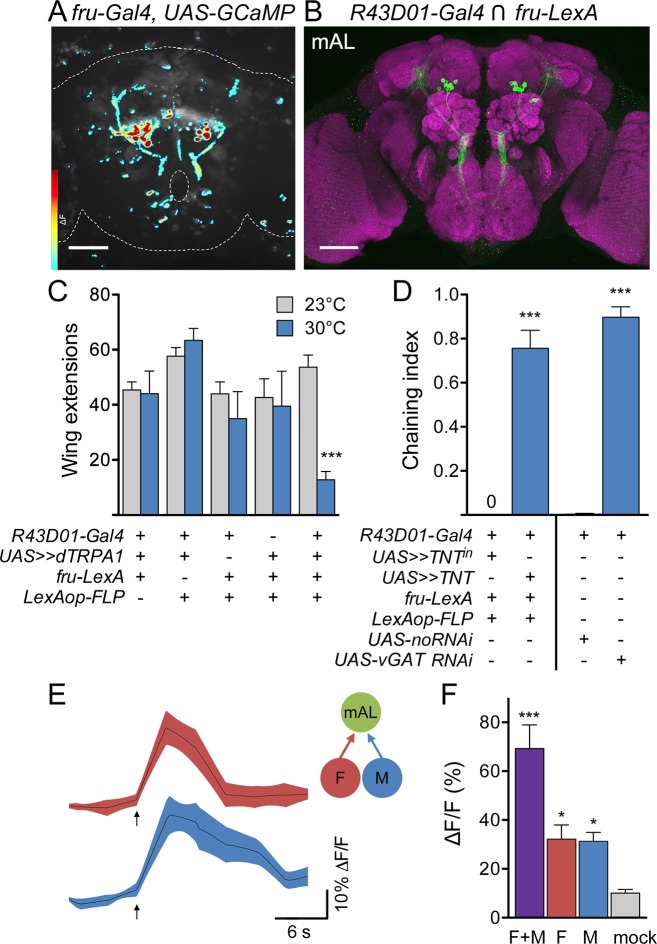
M cells and F cells activate courtship-suppressing mAL neurons.(A) Example image of a GCaMP6s ΔF heat map in fru-LexA neurons upon P2X2-mediated activation of F+M cells. (B) mAL neurons labeled by the intersection of R43D01-Gal4 and fru-LexA connect the SEZ and protocerebrum. (C) Activating mAL neurons with dTRPA1 suppresses courtship toward females; n = 10/condition. (D) Silencing mAL neurons with tetanus toxin or knocking down vGAT with R43D01-Gal4 induces male-male chaining; n = 8–10 groups/condition, 6–9 males per group. For C and D, >> means >stop>. Chaining index represents the fraction of time 3 or more males were courting over the 10-min trial. (E) P2X2-mediated stimulation of either F or M cells activates mAL neurons by GCaMP calcium imaging. Arrows indicate stimulus. (F) Maximum ΔF/F in mAL cell bodies; n = 5–9/condition. Mock is no P2X2. Scale bars, 50 μm (A, B). Data are Mean ± SEM, 2-way ANOVA, Bonferroni post-hoc (C), Mann-Whitney test (D), or Kruskal-Wallis test, Dunn’s post-hoc to mock (F). *p<0.05, ***p<0.001. See also Figure 5—figure supplement 1, for anatomical characterization of mAL neurons.